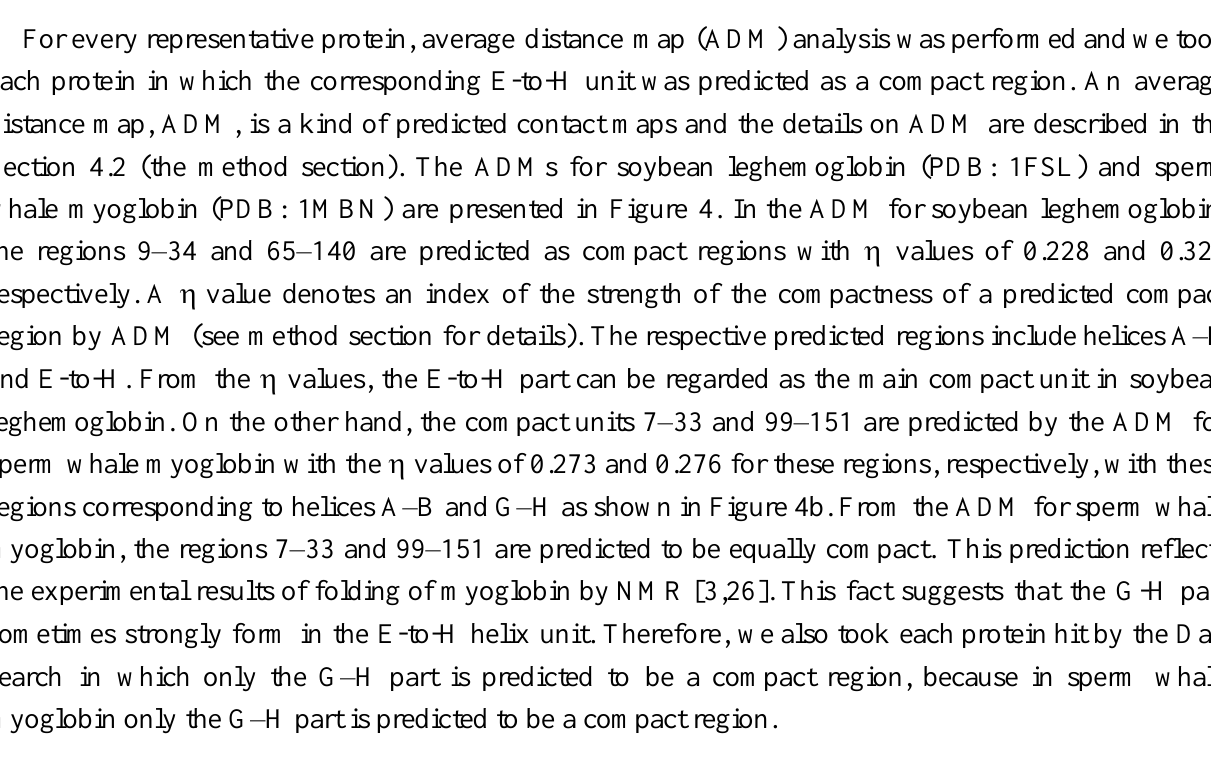
Figure 4. Average distance maps (ADM) for 1FSL ( a ), and 1MBN ( b ). The locations of the  -helices are labeled by A, B and so on. The label “9–34” denotes the compact region predicted by ADM. A numeral in parentheses indicates the  value of a compact region predicted by